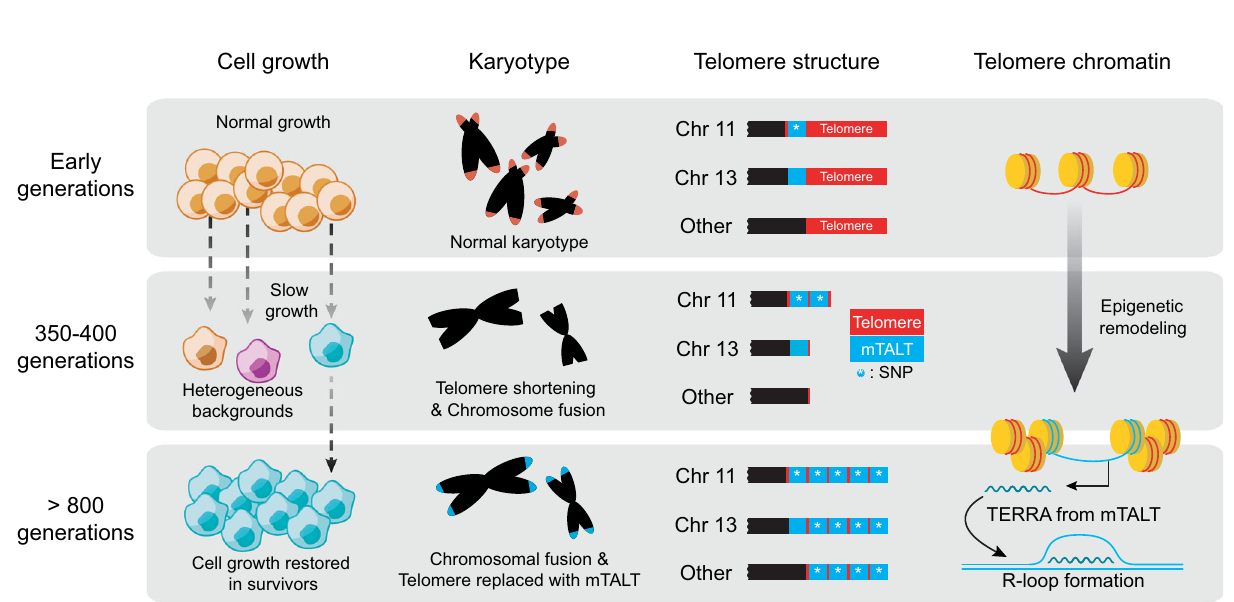
Fig. 6 A working model of ALT activation of mESCs. This fi gure summarises the emergence process of ALT mESC from various aspects. After the Terc gene was knocked out, cells of the early generation grew normally, but as the telomere length decreased growth slowed down and cells approached a senescent state. Affected by telomere shortening, genome-wide copy-number changes, and chromosomal fusions occurred, and transcriptional networks and cellular physiology changed accordingly. One or more cells activated ALT and were selected to form a homogenous post-ALT cell population. In an evolutionary time-line, the mTALT sequence was located at chromosome 13 fi rst, and at a certain point, replicated at the end of chromosome 11. In the process of telomere shortening, the only mTALT of chromosome 11 underwent selective duplication, and during ALT activation, the mTALT of chromosome 11 was ampli fi ed in cis and trans to cover all telomeres. Through transcriptome and proteome analyses, we con fi rmed that genome-wide epigenetic remodelling occurred during the ALT activation process, and the expression of telomeric transcripts and R-loop formation increased due to HMGN1- dependent telomeric changes, contributing to telomere